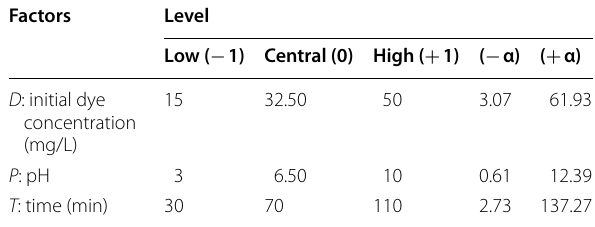
Table 1 Matrix for the central composite design